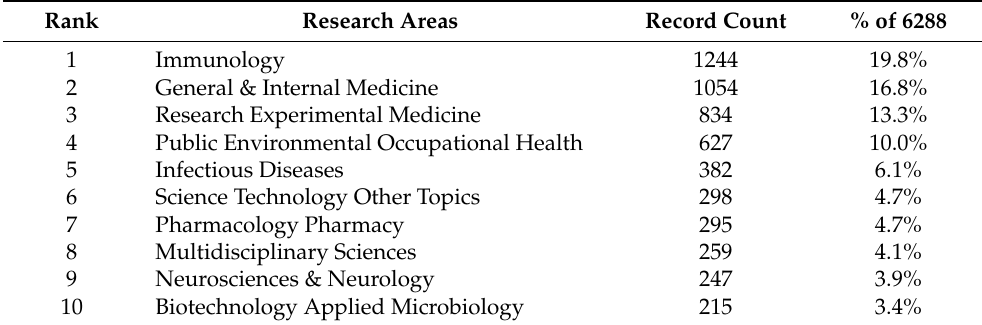
Table 6. Active research areas in COVID-19 vaccine